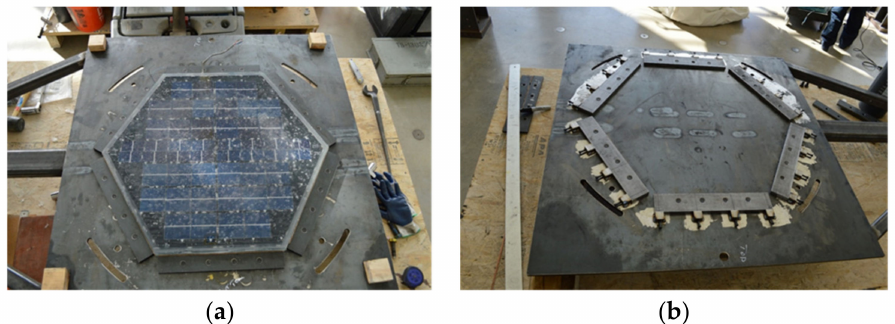
Figure 12. ( a ) Front of test fixture with original steel grips and a paver installed; ( b ) front of test fixture with reinforced grips.